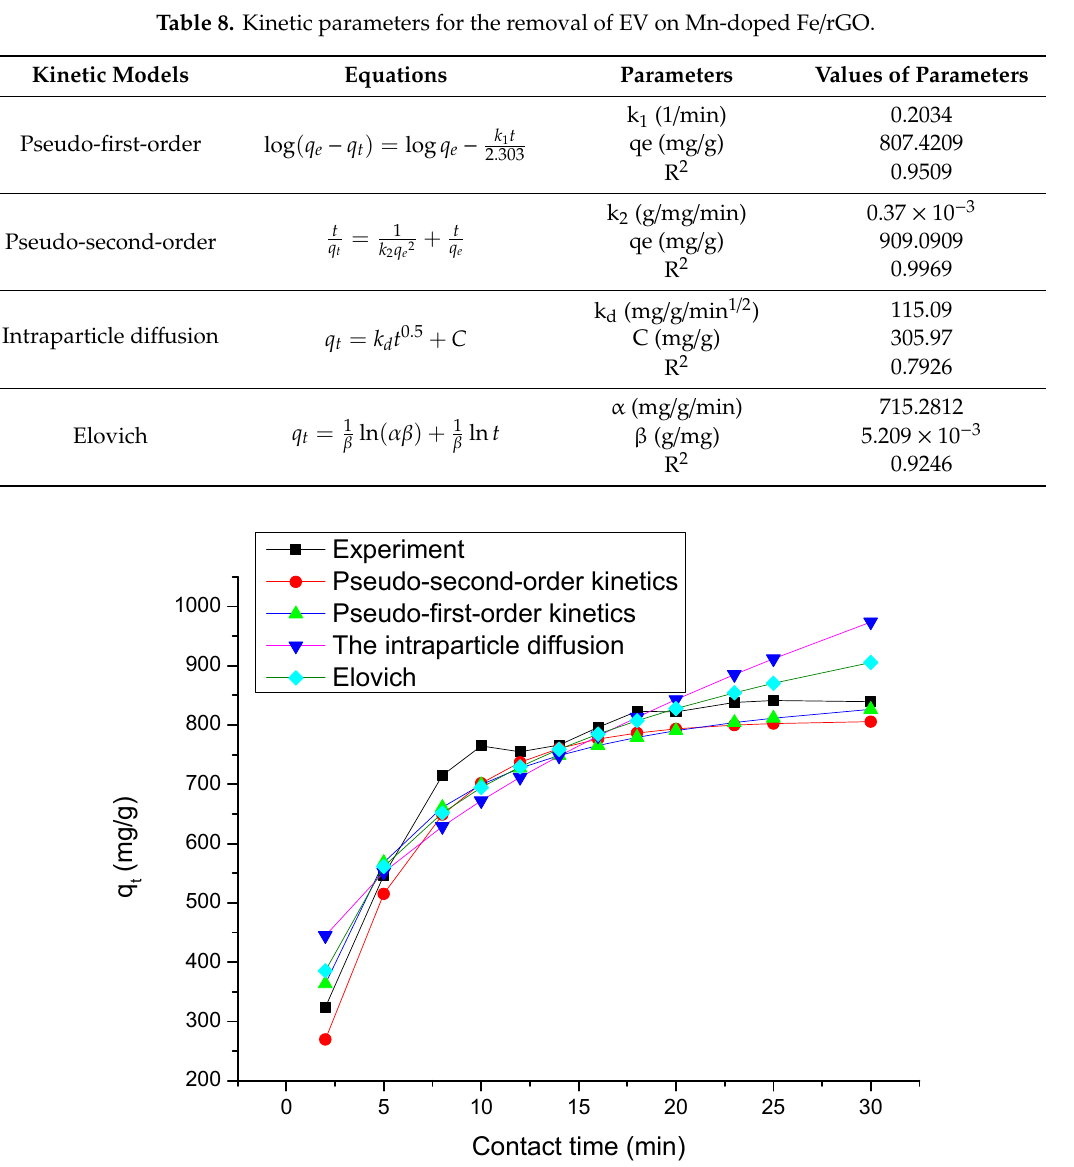
Figure 26. Time dependent study of EV removal by Mn-doped Fe/rGO (initial pH = 5.0; Mn-doped Fe/rGO dosage = 20 mg; EV concentration = 500 mg/L).